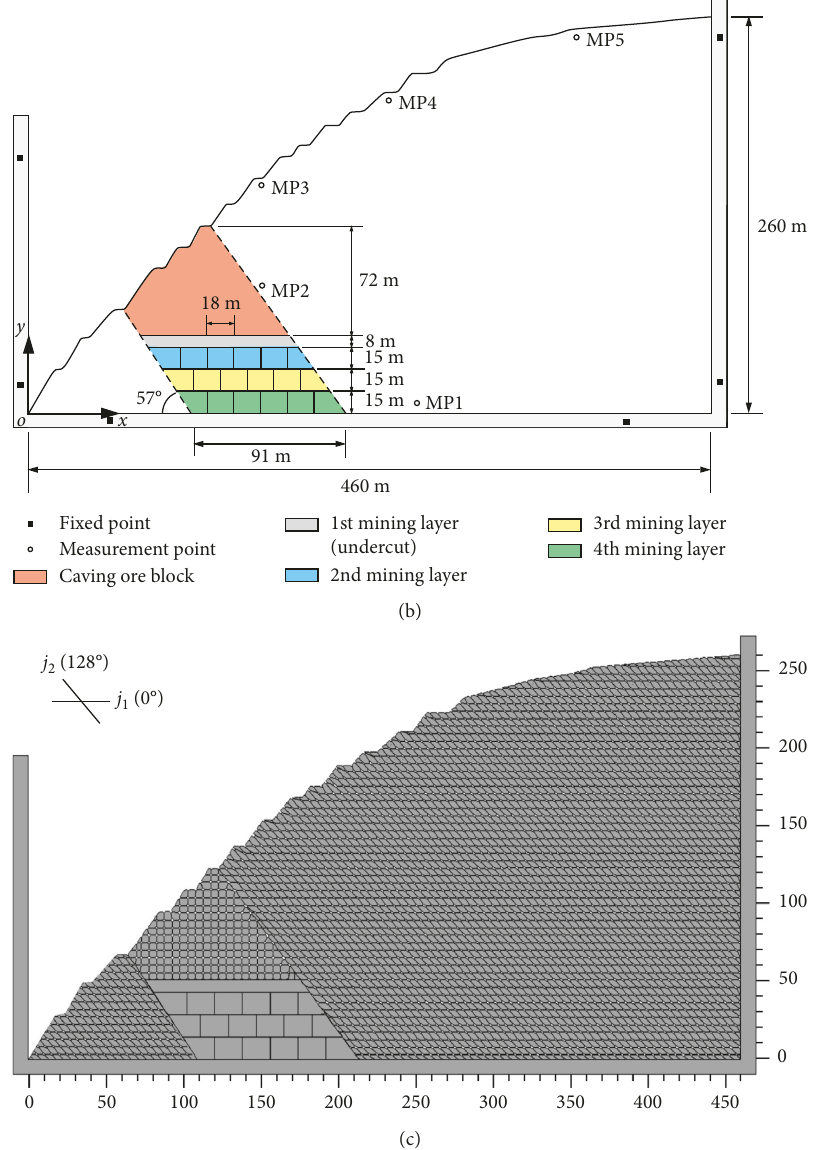
section. (b) Model geometry and distribution of ′